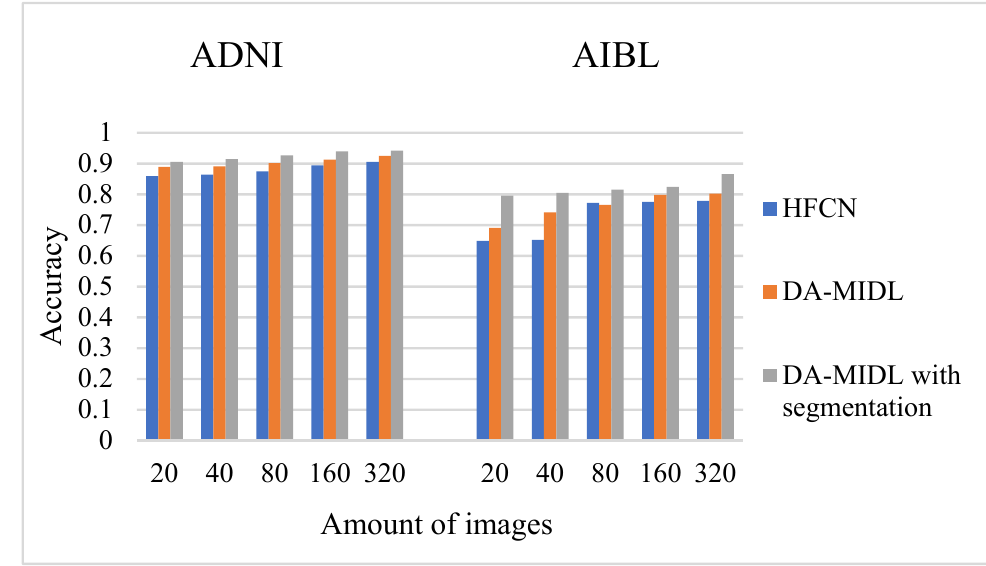
Figure 4. Accuracy comparison outcomes between DA-MIDL, HFCN, and the proposed DA-MIDL with segmentation.